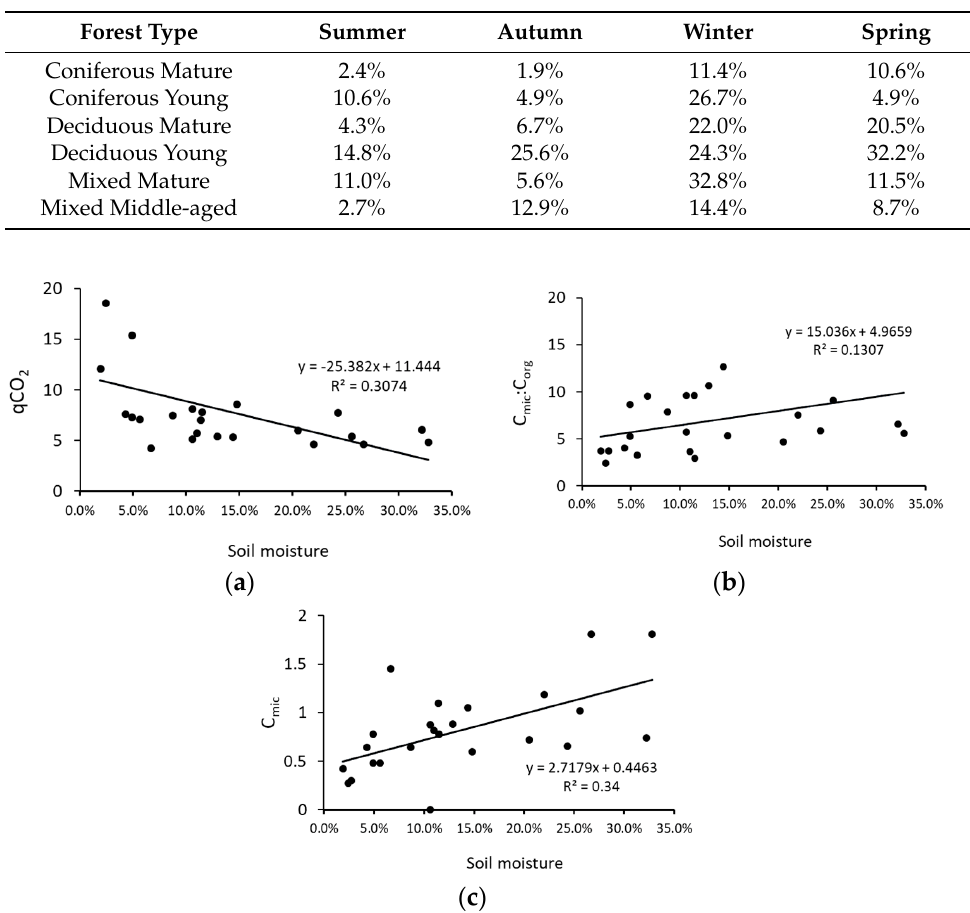
Figure A1. Correlations between soil moisture content and microbial parameters based on mean values for each season for all studied forests ( n = 24) ( a – c